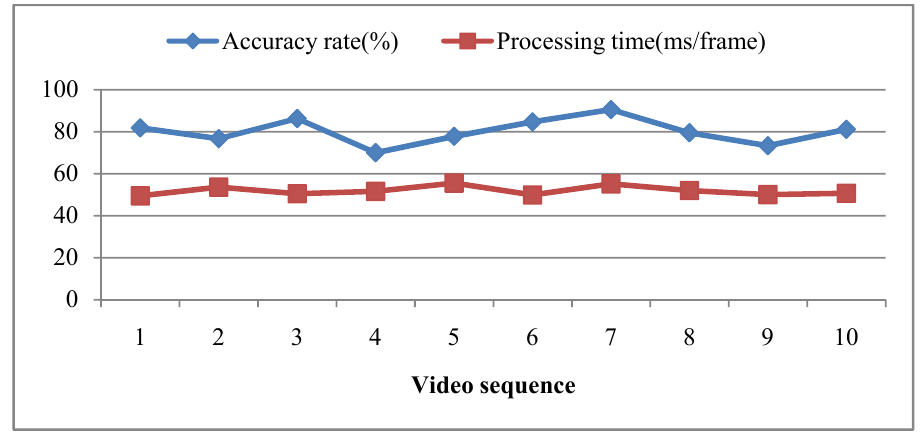
Figure 12. The experimental results for the 10 testing video sequences.